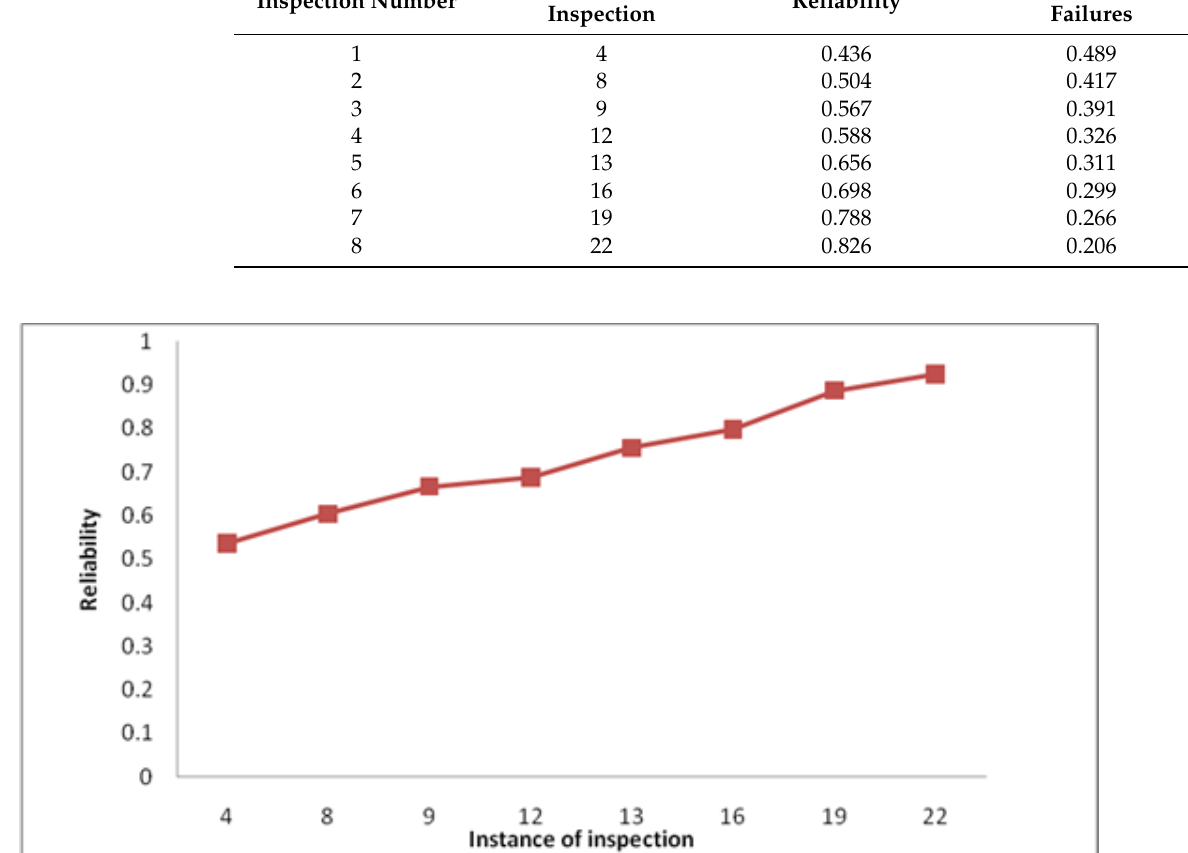
Figure 2. Relationship between expected reliability and number of inspections.